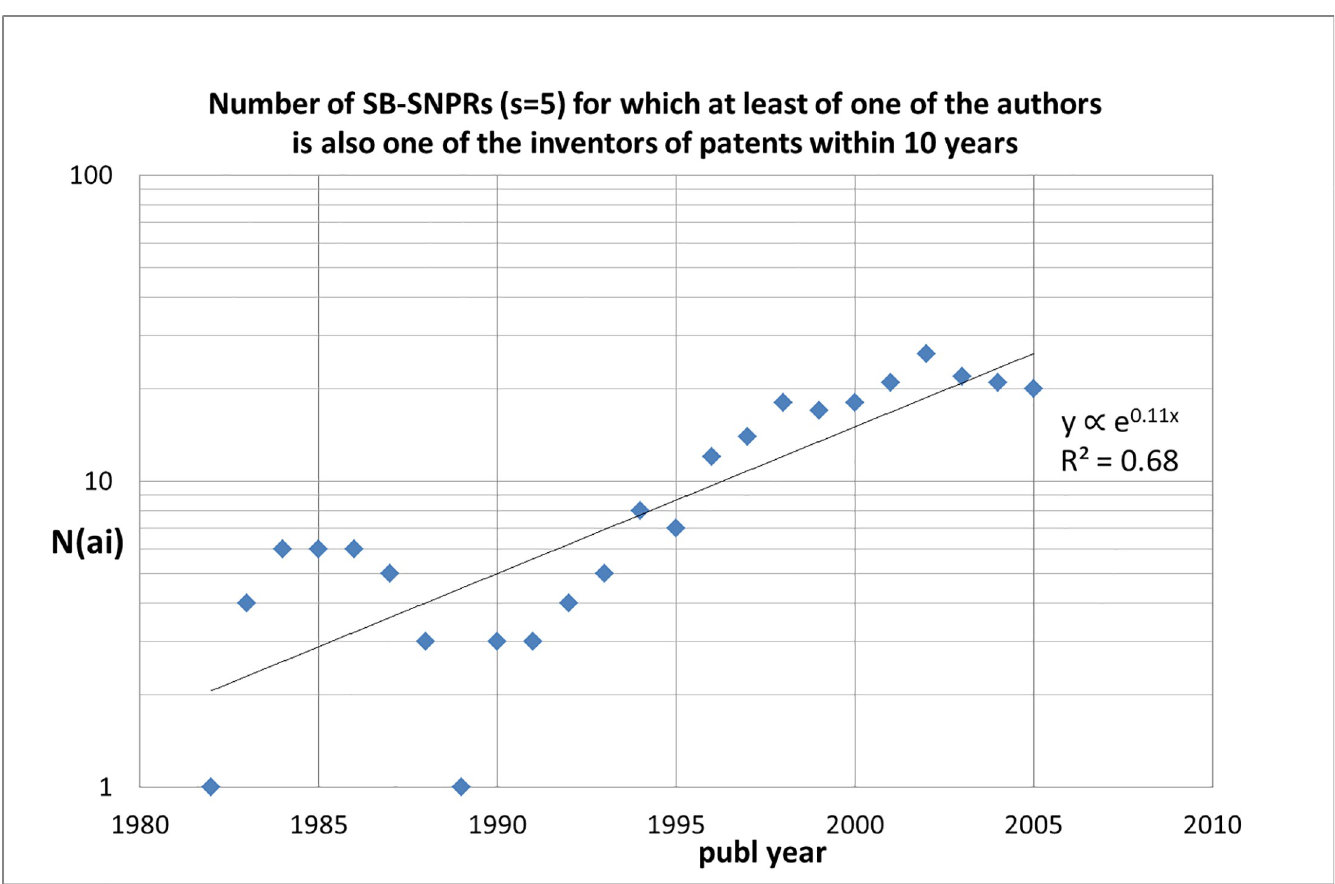
Fig 19. Number of SB-SNPRs ( s = 5) of which at least one of the authors is also one of the inventors of the citing patent (N(ai)) as a function of the publication year of the SB-SNPRs.